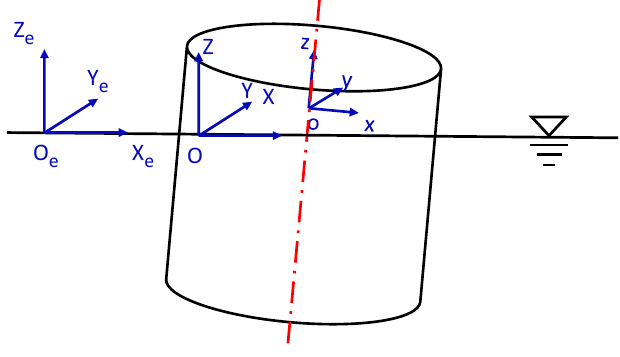
Figure 1. Definition of three coordinate systems: O e X e Y e Z e , OXYZ and oxyz